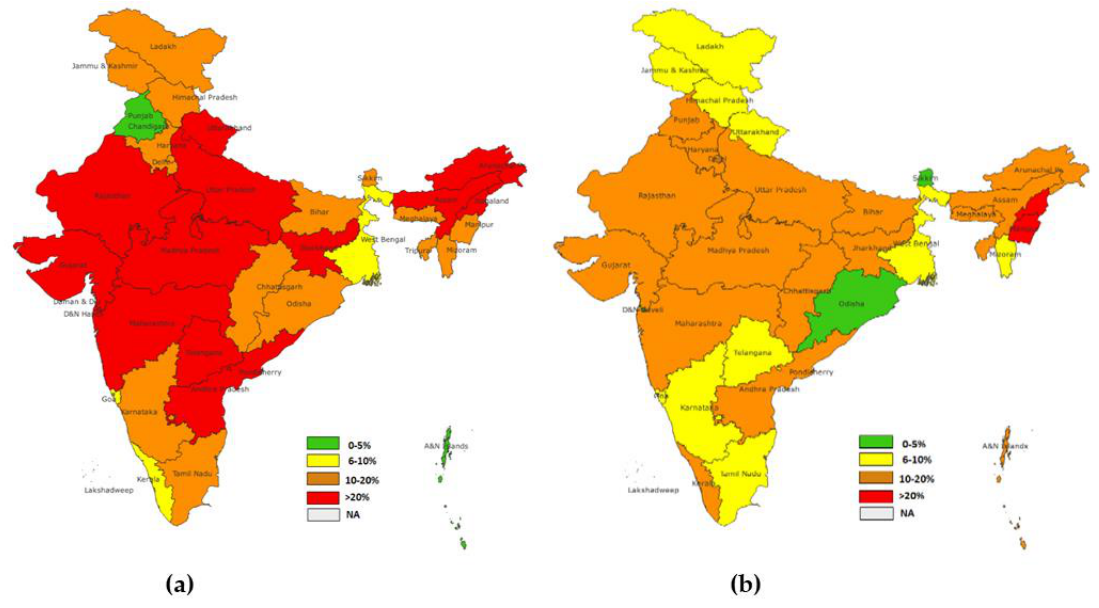
Figure 5. ( a ) State level dropout rate for OPV1-OPV3 (NFHS-4), ( b ) state level dropout rate for OPV1-OPV3 (NFHS-5).